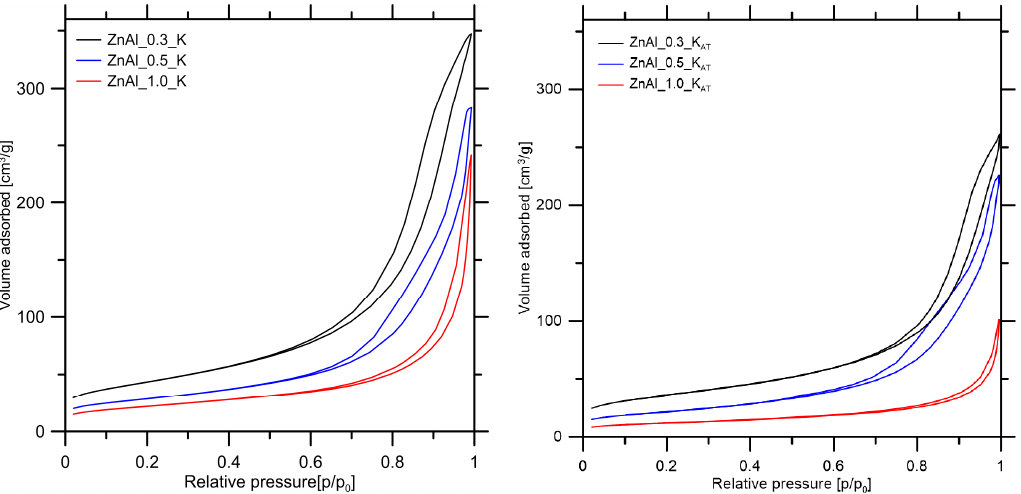
Figure 5. N 2 adsorption–desorption isotherm of ZnAl_X_K and ZnAl_X_K AT catalysts with different Zn/Al molar ratios.